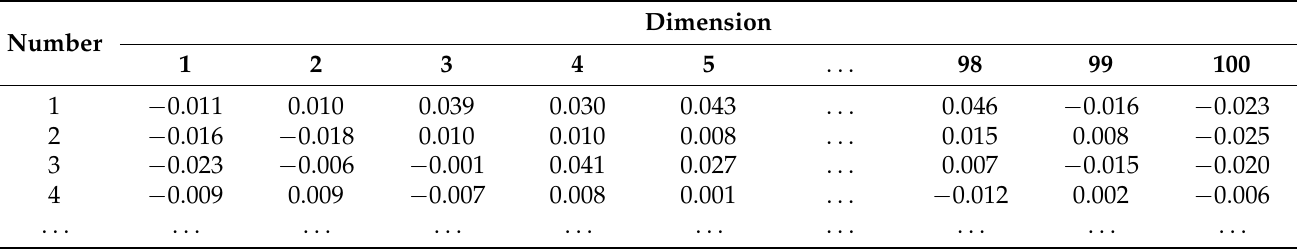
Table 4. UAV fault phenomenon recording text feature vector extracted by Word2Vec.